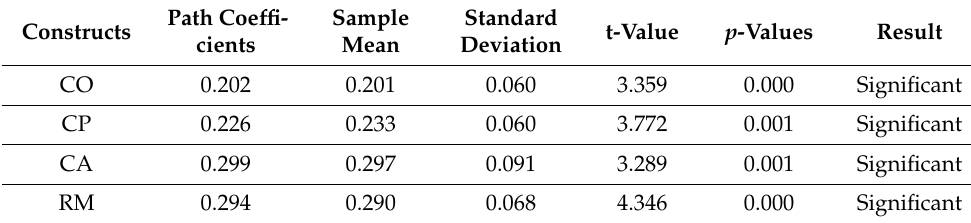
Table 3. Structural model